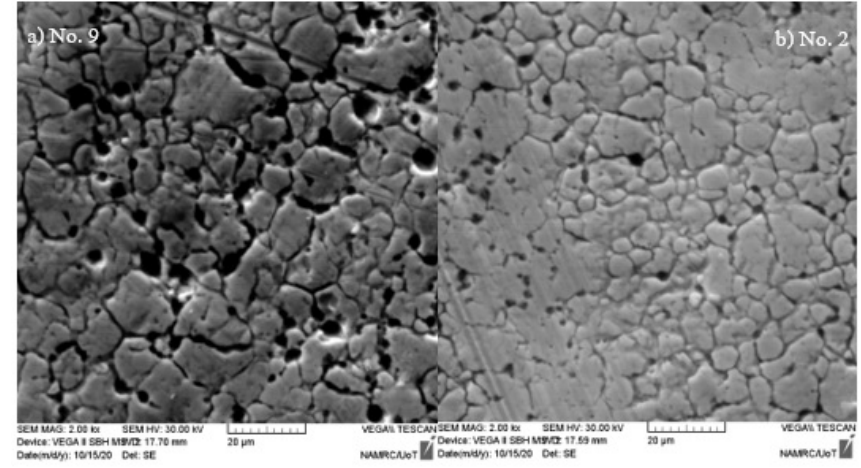
Figure 6. SEM of the two samples no.2 and no.9 after corrosion